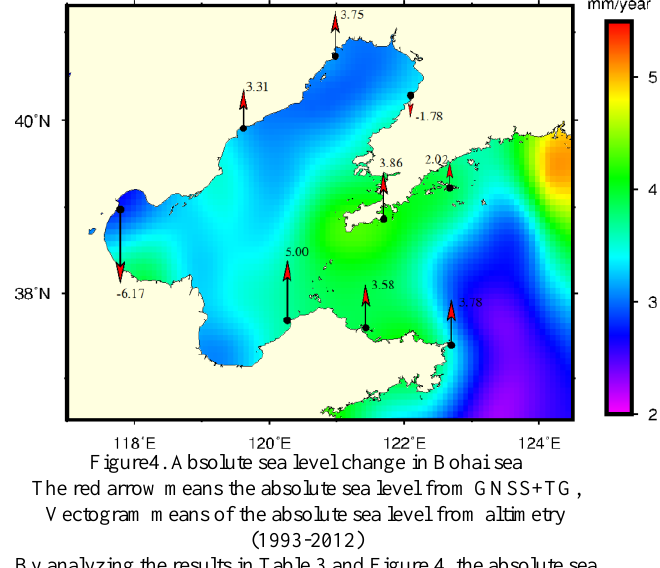
Figure4. Absolute sea level change in Bohai sea The red arrow means the absolute sea level from GNSS+TG, Vectogram means of the absolute sea level from altimetry